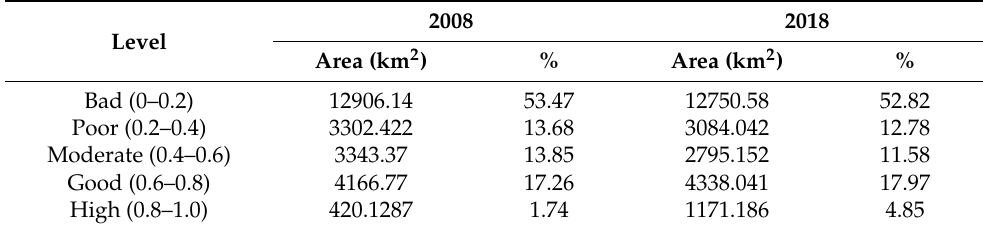
Table 4. Area and proportion of MODEI level in 2008 and